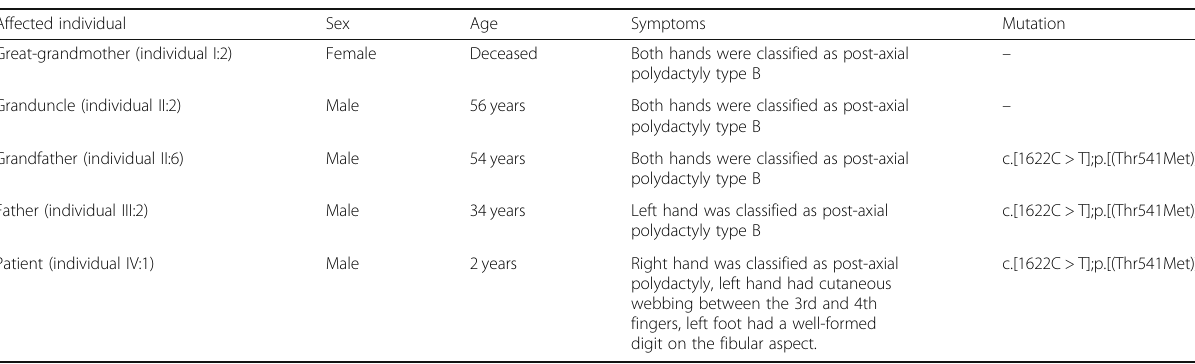
Table 1 Clinical features of the affected